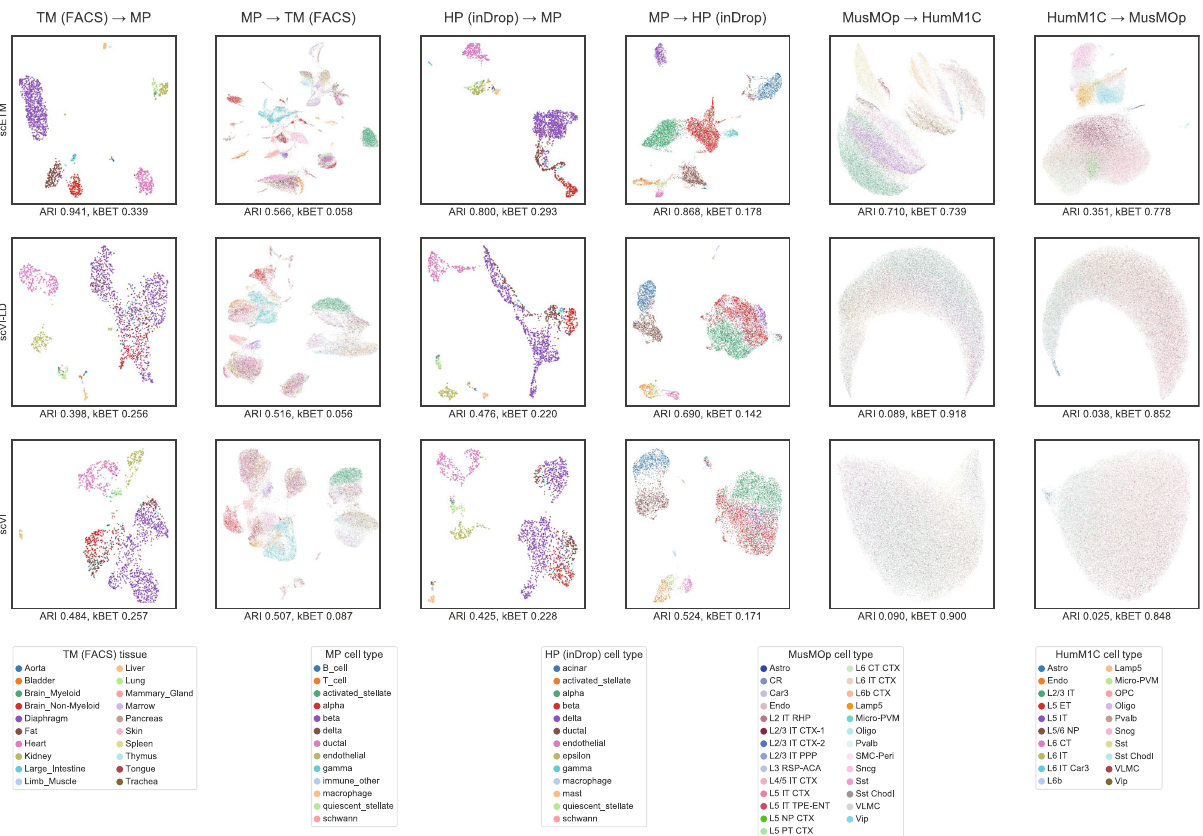
Fig. 4 Cross-tissue and cross-species zero-shot transfer learning. Each panel displays the UMAP visualization of cells by training on dataset A and the applied to dataset B (i.e., A → B). In total, we performed 6 transfer-learning tasks: TM (FACS) ↔ MP, HP (inDrop) ↔ MP, MusMOp ↔ HumM1C. For each task, we evaluated scETM, scVI-LD, or scVI, which are the rows in the above fi gure. The cells are colored by tissues or cell types as indicated in the legend. The corresponding ARI and kBET are indicated below each panel. For MP → TM (FACS), we evaluated the ARI based on the 92 cell types although we colored the cells by the 20 tissues of origin instead of their cell types because of the large number of cell types. Abbreviations: TM (FACS): tabula muris sequenced with fl uorescence-activated single-cell sorting; MP: mouse pancreas; HP (inDrop): human pancreas sequenced with InDrop